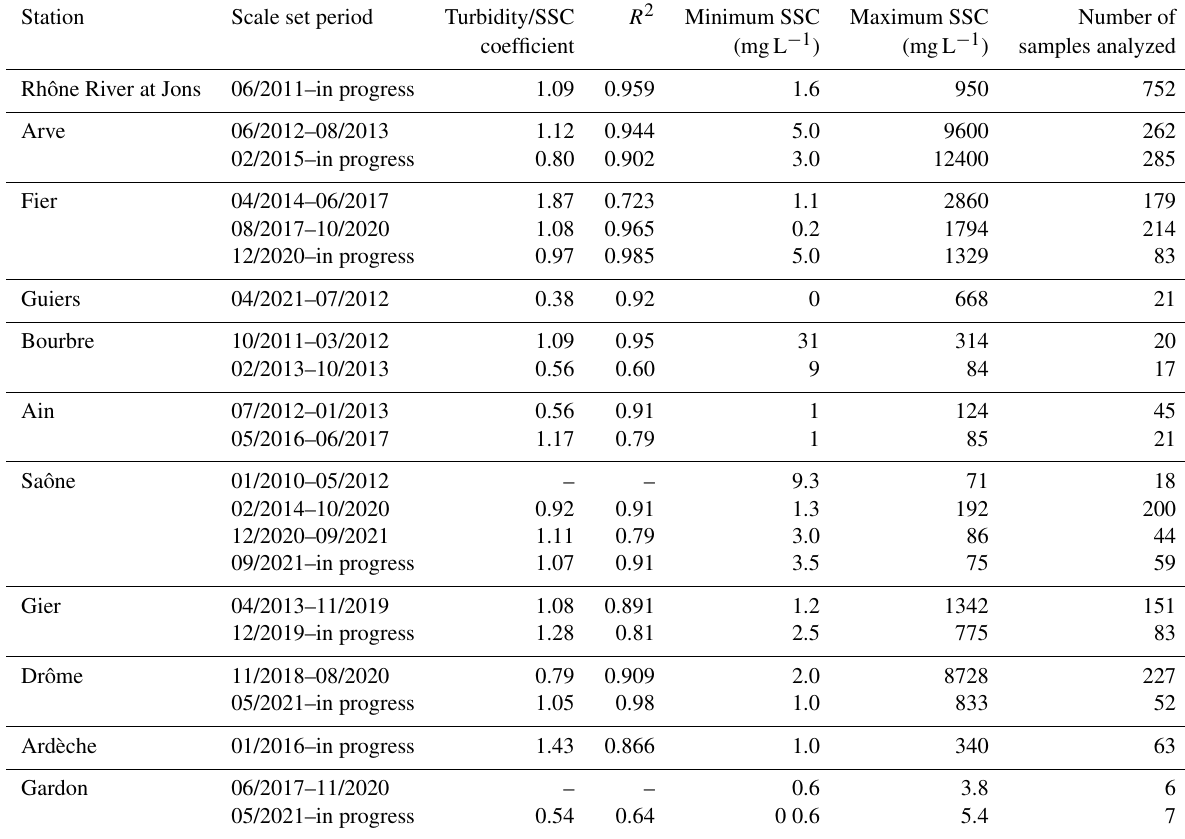
Table 4. Calibrations of turbidimeter and